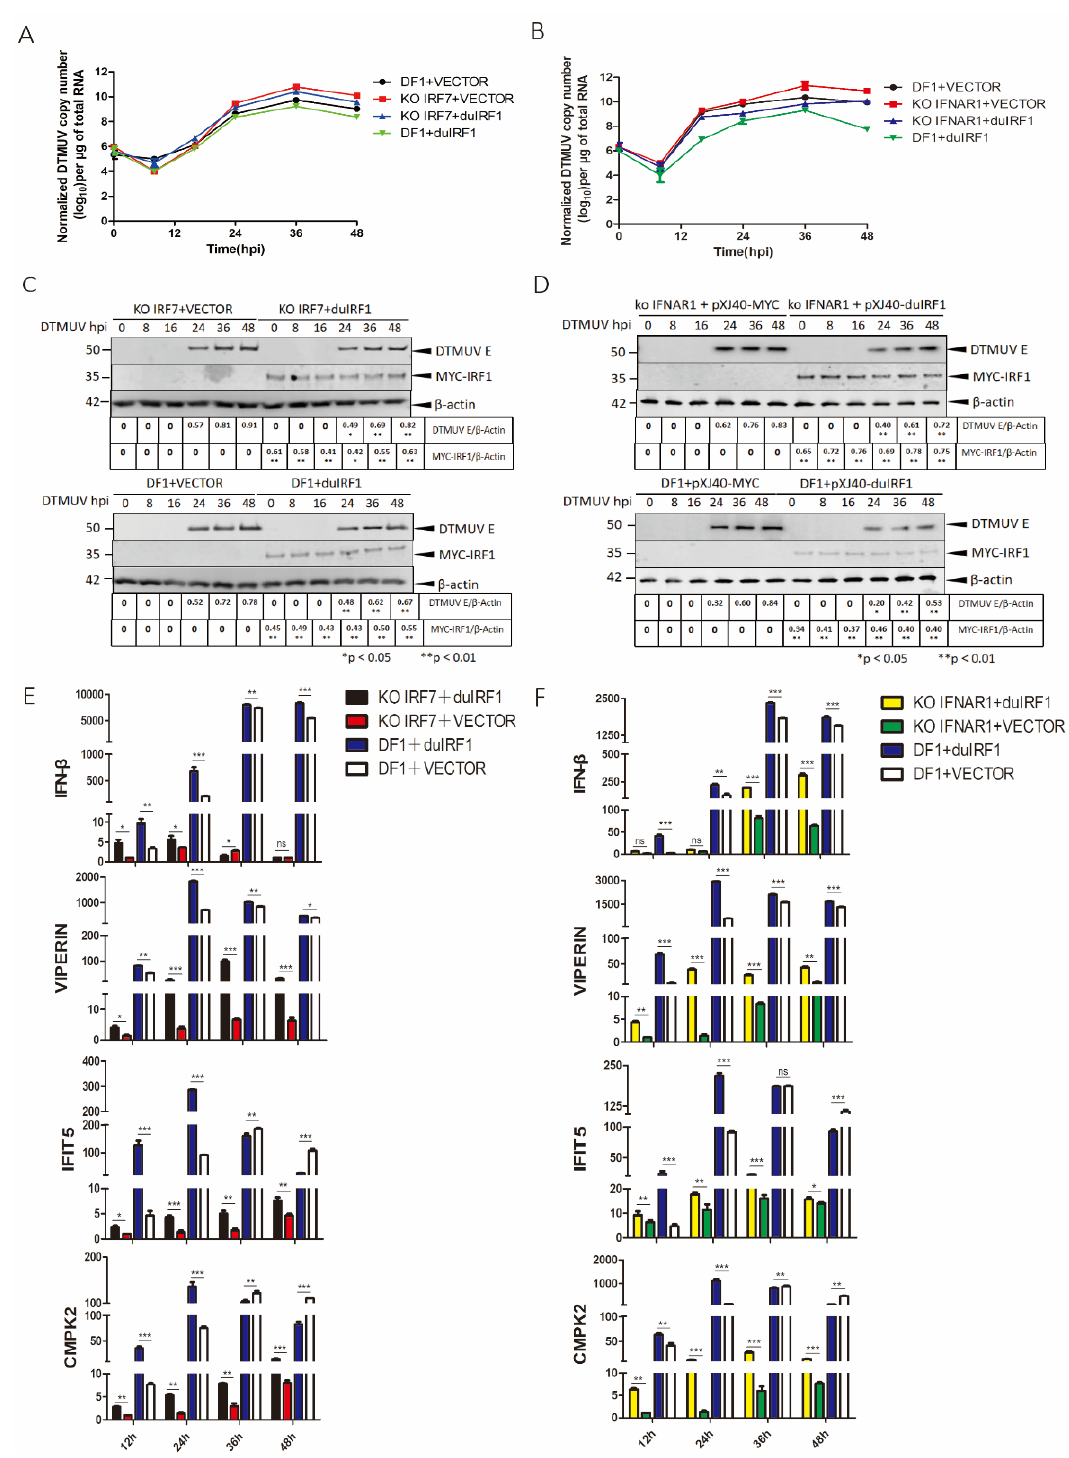
Figure 4. Inhibition of DTMUV replication and regulation of the expression of IFN- β, VIPERIN, IFIT5, and CMPK2 induced by overexpression of duck IRF1 in KO IRF7 and KO IFNAR1 cells. ( A ) DF1 and KO IRF7 cells were transfected with a Myc-tagged duIRF1, infected with DTMUV at an MIO of approximately 2, and harvested at 12, 24, 36, and 48 hpi, respectively. Total RNAs were extracted, and the copy numbers of the viral genomic RNA were determined by RT-qPCR and presented. ( B ) DF1 and KO IFNAR1 cells were transfected with a Myc-tagged duIRF1, infected with DTMUV at an MIO of approximately 2, and harvested at 12, 24, 36, and 48 hpi, respectively. Total RNAs were extracted, and the copy numbers of the viral genomic RNA were determined by RT- qPCR and presented. ( C ) DF1 and KO IRF7 cells were transfected with a Myc-tagged duIRF1, in-